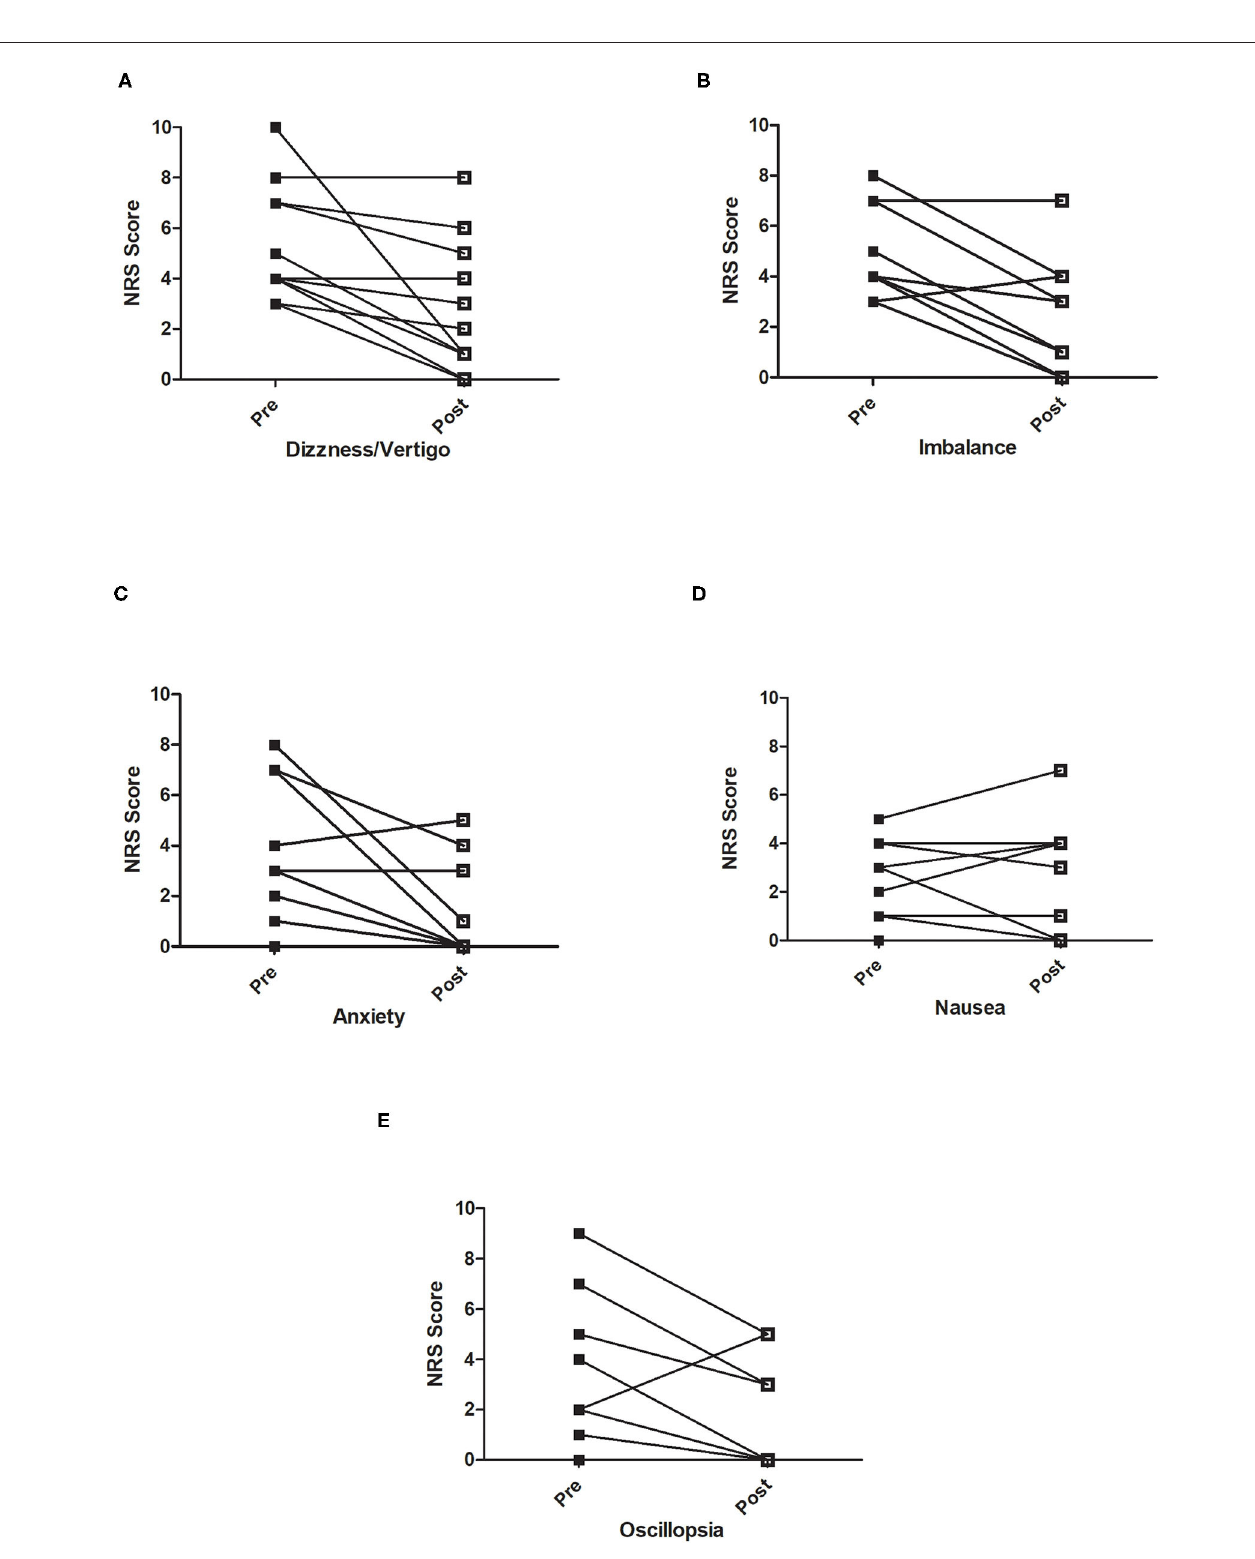
FIGURE 3 | Pre- and post-treatment numerical rating scale scores for (A) Dizziness/vertigo, (B) Imbalance, (C) Anxiety, (D) Nausea, and (E) Oscillopsia. Participants rated symptoms daily on a 0–10 scale with 0 anchored as “none” and 10 as “symptom as bad as it could be.” Each participant is represented on a graph with closed squares showing the pre-treatment score and a line linking to the post-treatment score (open square).